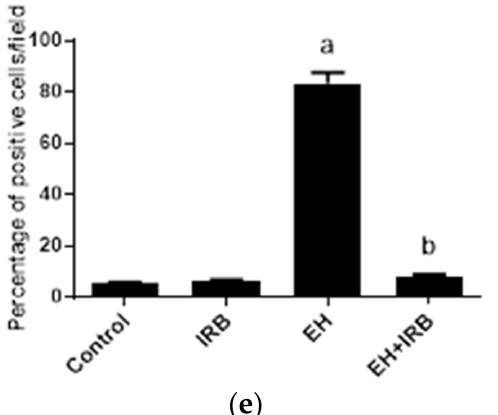
Figure 3. Effect of irbesartan (IRB) on uterine survivin immunohistochemical staining in estradiol benzoate-induced endometrial hyperplasia (EH) and atypia in rats. Images are representative sections of the rat uterus (×400) stained for detection of survivin in ( a ) control, ( b ) IRB-treated, ( c ) EH, and ( d ) EH+IRB-treated groups. Semiquantitative analysis of survivin expression in different groups was carried out ( e ). Results represent the mean ± SEM ( n = 6–7) of the percentage of survivin positive cells/field. a,b Significantly different ( p < 0.05) from control and EH groups, respectively.